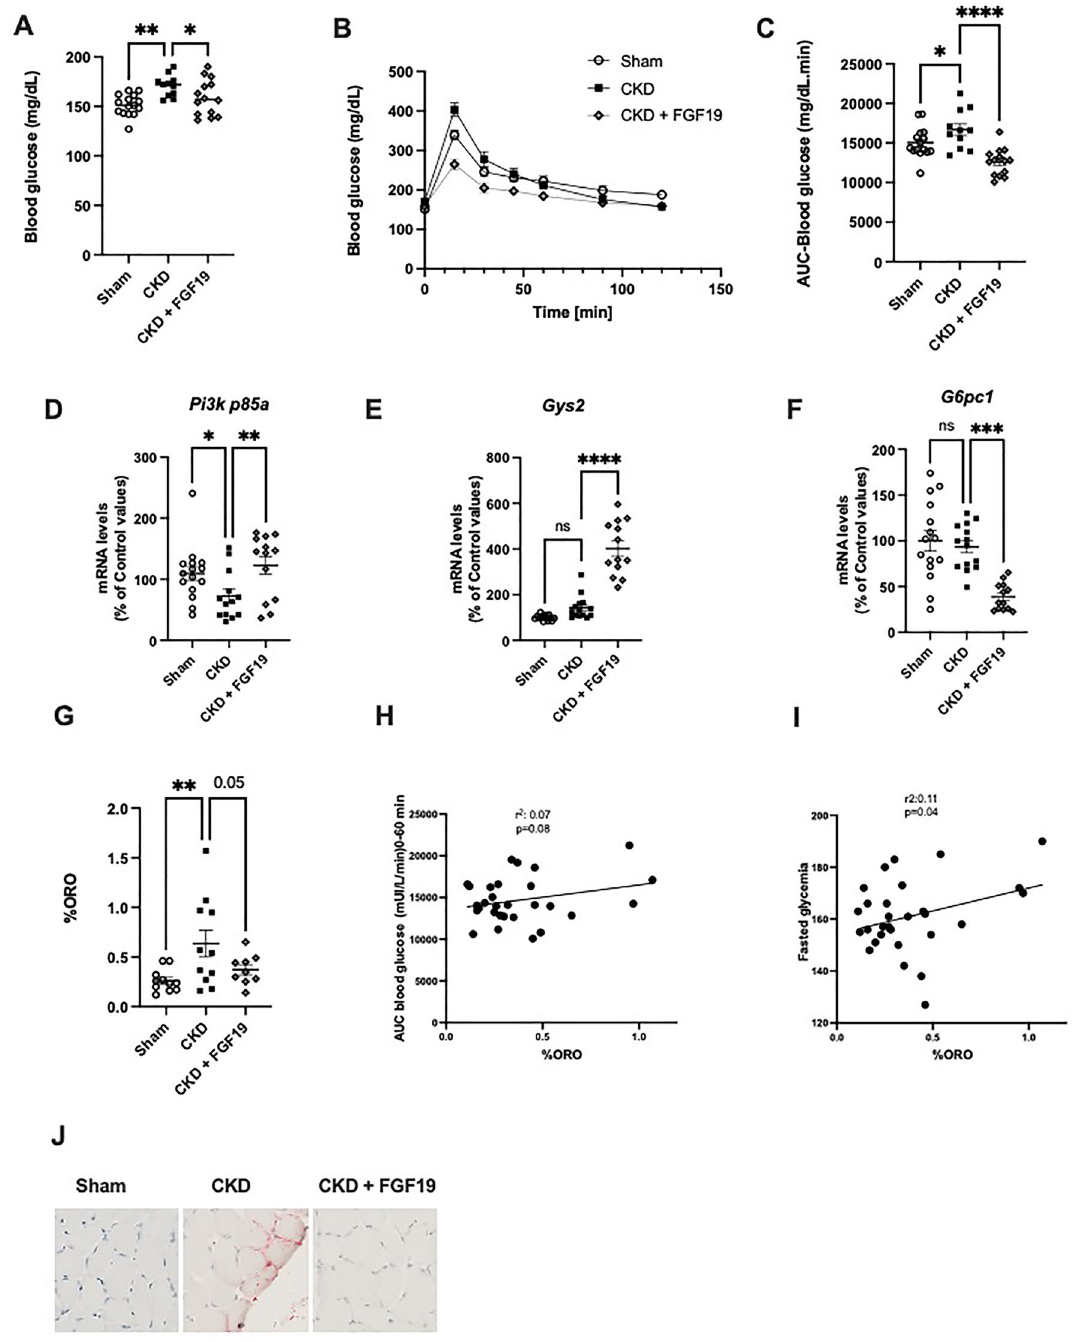
Figure 4. FGF19 corrects uremia-mediated insulin resistance in association with suppressed hepatic gluconeogenesis genes expression. ( A ) Fasted blood glucose. ( B ) Glucose levels during an i.p. GTT (2 g/kg) and ( C ) AUC (0–60 min) in control and CKD mice after FGF19 or vehicle treatment. Relative mRNA expression of ( D ) Pi3K p85a ( E ) Gys2 and ( F ) G6pc1 in Sham and CKD mice after FGF19 or vehicle treatment. ( G ) Percentage of Oil Red O staining of soleus muscle in Sham and CKD mice after FGF19 or vehicle treatment. Relationship between Oil Red O staining of soleus muscle and ( H ) fasted glycemia or ( I ) AUC glucose during ip-GTT. ( J ) Representative images of muscle sections stained with Oil Red O. Tbp (TATA-Box Binding Protein) was used as reference gene to normalize the results. Results are expressed as the ratio of target mRNA levels to housekeeping gene mRNA levels and normalized to the levels in Sham mice. Data are expressed as mean ± SEM for n = 9–15 animals in each group. Statistical analysis was done using a one-way ANOVA test * p < 0.05, ** p < 0.01, *** p < 0.001. Abbreviations: AUC: area under curve, CKD: chronic kidney disease, G6pc1 : glucose-6- phosphatase, Gys2 : glycogen synthase, Pi3k : phosphoinositide 3-kinase, n.s., not